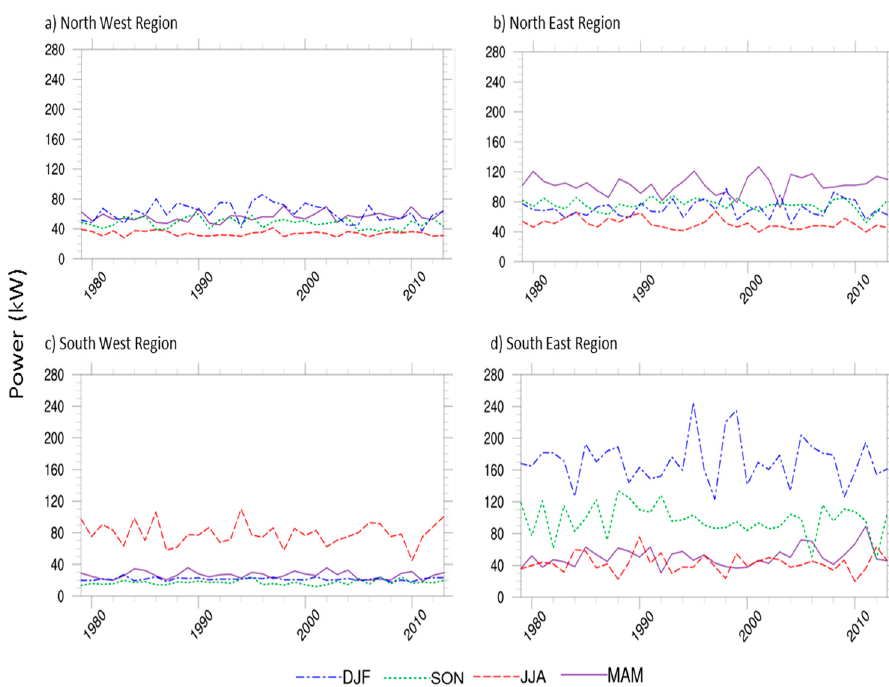
Figure 8. Annual seasonal averages of wind power for the four seasons over ( a ) North West region, ( b ) North East region, ( c ) South West region, and ( d ) South East region.